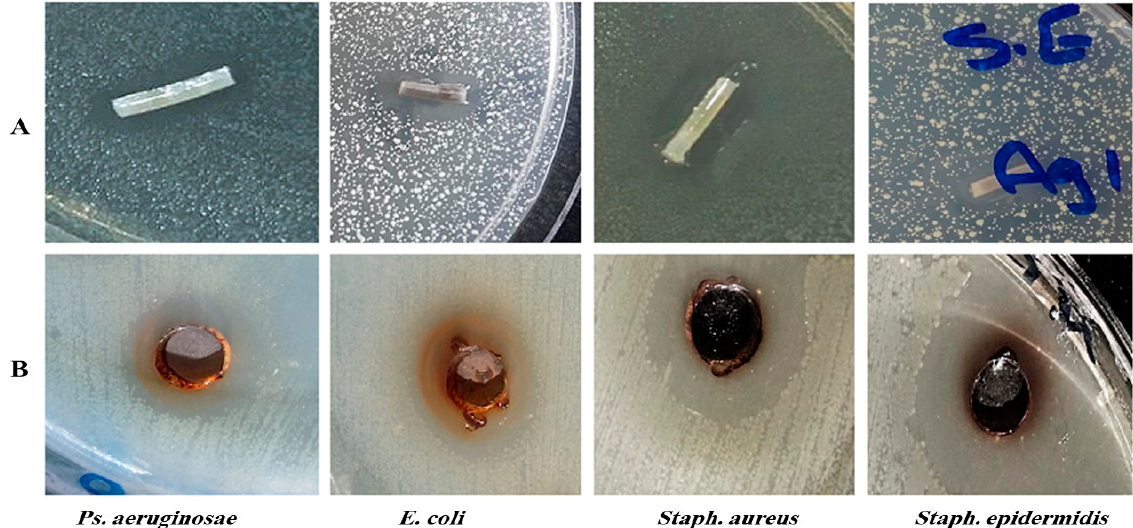
Figure 4. The inhibitory effect of catheters impregnated in AgNPs/mastic varnish on the different tested bacteria. ( A ) Top figures represent the inhibition zones produced by the pieces of the varnished catheters. ( B ) The bottom figures represent the inhibition of bacteria by AgNPs by the cup–plate method.